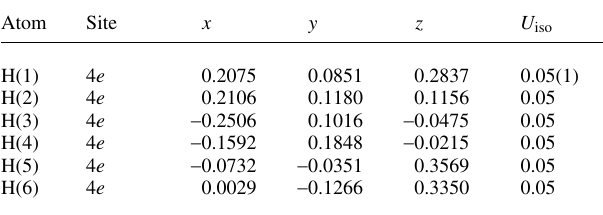
Table 4. Data collection and handling. Table 5. Atomic coordinates and displacement parameters (in Å 2 ) .